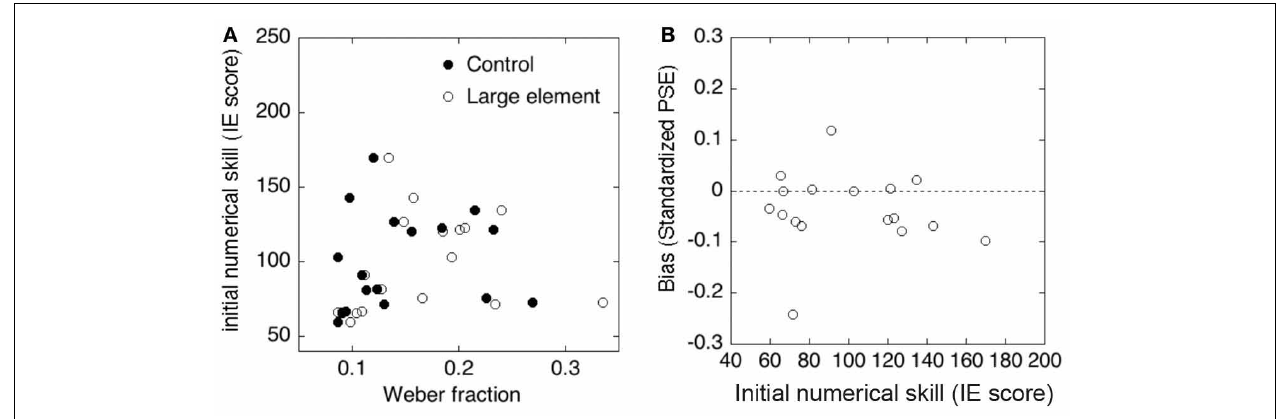
FIGURE 4 | (A) Correlations between the Weber fraction and initial numerical skill (inverse efficiency scores) in the control and large element conditions. (B) Correlation between the initial numerical skill and the standardized PSE (i.e., size of bias).